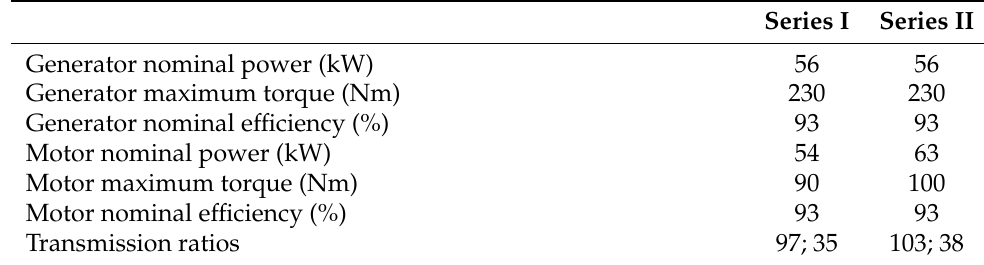
Figure 9. Schematic representation of the series architecture. Table 5. Main properties of the series